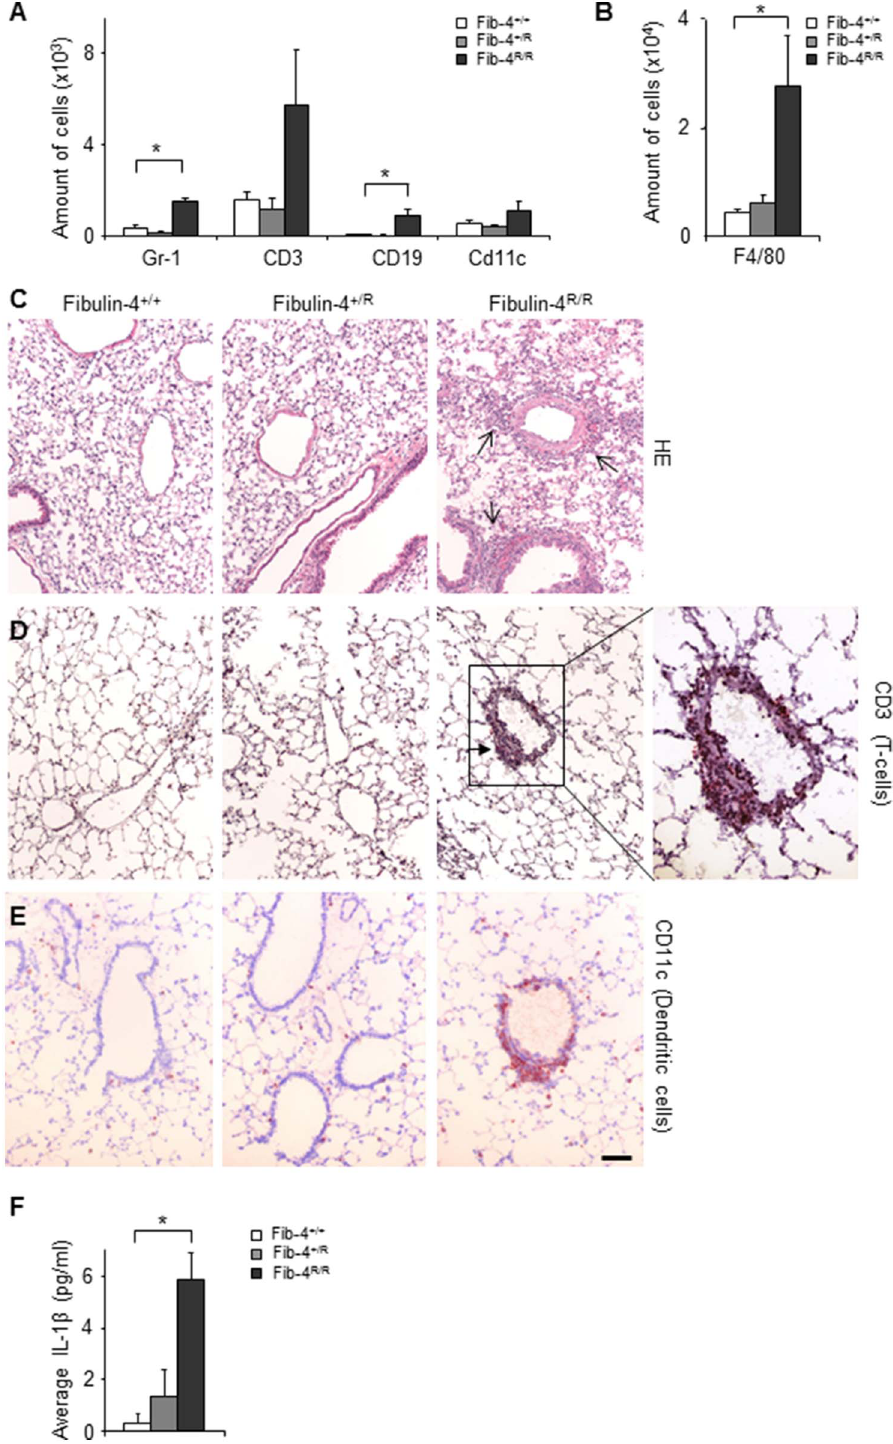
Figure 4. Increased inflammation in Fibulin-4 R/R lungs compared to Fibulin-4 + / + and Fibulin-4 + /R lungs. (A) Flow cytometric analysis revealed more Gr1 + granulocytes and CD19 + B-cells in BAL samples from Fibulin-4 R/R (n=4) compared to Fibulin-4 + / + mice (n=4, *p , 0.05) and (B) increased numbers of F4/80 macrophages in Fibulin-4 R/R lungs (n=4, *p , 0.05). (C) HE stained sections from adult (n=4, n=4, n=4) Fibulin-4 + / + , Fibulin-4 + /R and Fibulin-4 R/R lungs showing focal infiltrations around vessels and airways in Fibulin-4 R/R lungs (black arrows). (D) Staining for T-cells (CD3 + ) and (E) dendritic cells (CD11c + ) points to the presence of inflammatory cells within the focal infiltrations. Magnification 20x. Scale bar 50 m m. (F) ELISA analysis showing increased IL-1 b levels in Fibulin-4 R/R lungs (n=4, *p , 0.05).